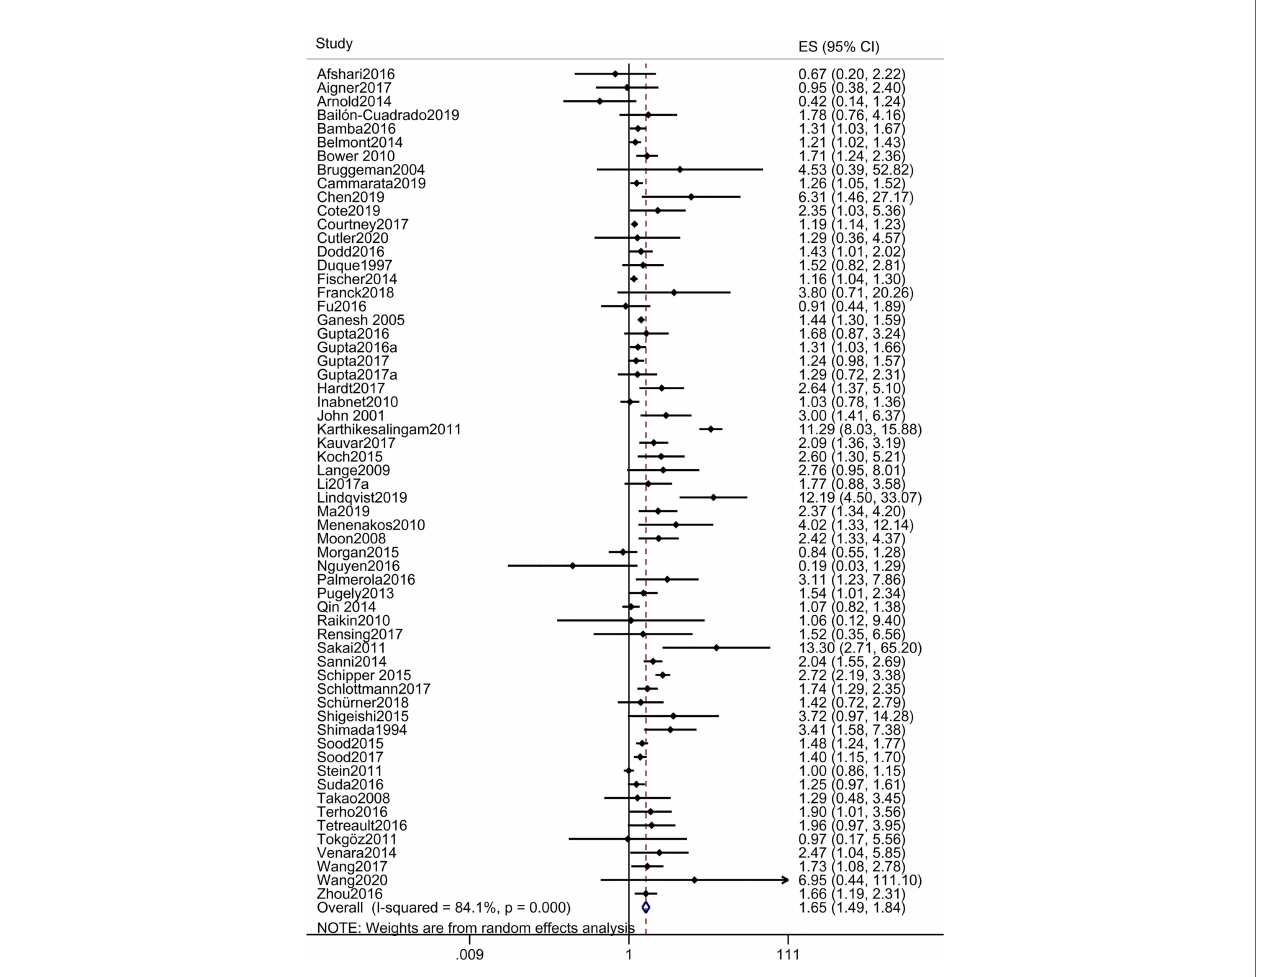
FIGURE 2 | Forest plot of odds ratio of any postoperative complication in patients with DM vs those without